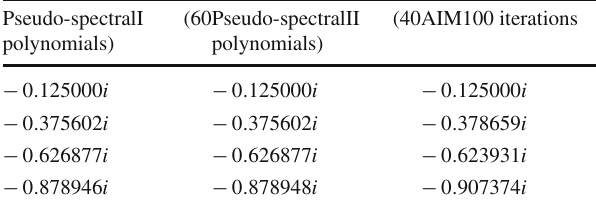
Table 8 Purely imaginary frequencies of spin 5 / 2 perturbations nor- malized by the mass ( M ω)